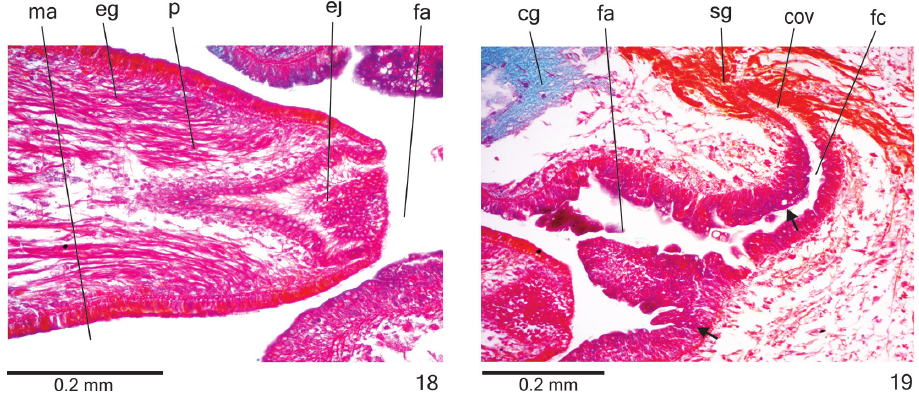
Figures 18–19. Cratera cryptolineata sp. n., holotype, sagittal sections, 18 penis papilla 19 female organs. Arrows indicate